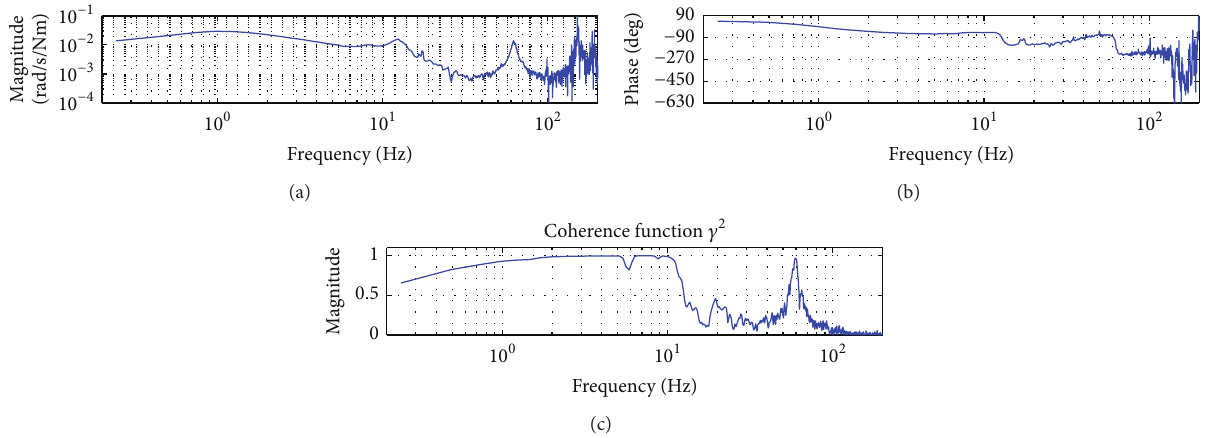
̇ 𝜃 𝑇 3 / 5 : modulus (a), phase (b), and coherence function